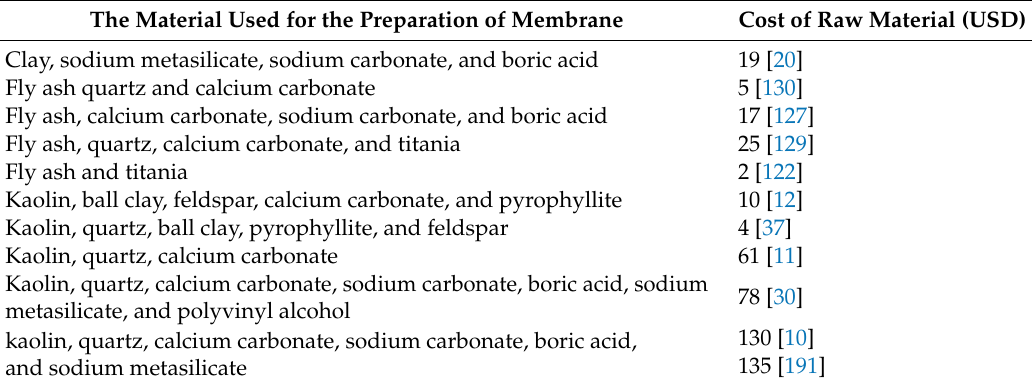
Table 5. Raw material price for the fabrication of 1 m 2 membrane, reported in the